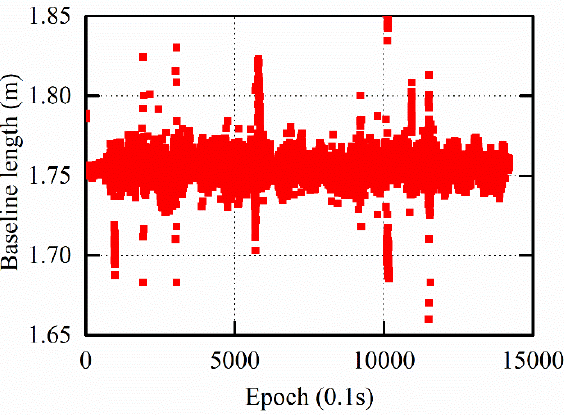
Figure 12. Dynamic baseline length.